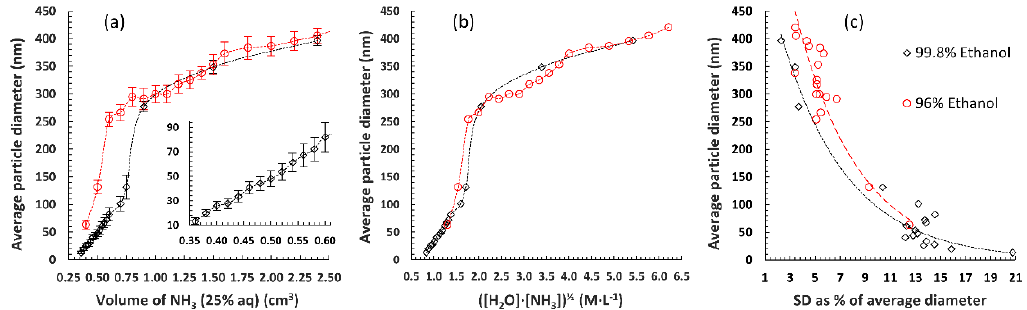
Figure 1. Results of nanosilica synthesis using aqueous ammonia solution and different grades of ethanol as the solvent. ( a ) Average diameter as a function of NH 3 volume (per 10 cm 3 of reaction mixture, 0.4 cm 3 of tetraethylorthosilicate (TEOS)) with error bars used to denote the standard deviation (SD) in size; expanded section shows changes in the lower particle size range, obtained by varying the ammonia volume by 20 µ L steps. ( b ) Superimposition of both experimental curves after taking into account the real amount of water in the system and calculating the square root of the product of concentrations of both reagents. ( c ) Relationship between %SD and the average size of obtained nanoparticles, showing a logarithmic decrease in %SD with rising particle size.